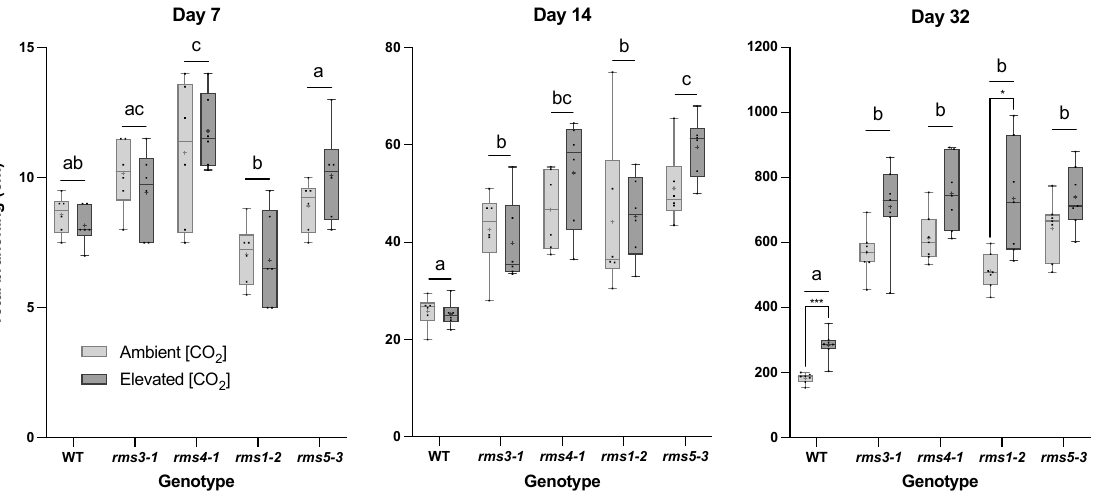
Figure 2. The effect of high CO 2 on the branching of the shoots of wild type peas and mutants defective either in strigolactone (SL) synthesis ( rms1 - 2 and rms5-3 ) or signaling ( rms3 - 1 and rms4-1 ). Plants were grown for up to 32 days either under ambient (420 ppm) or high CO 2 (750 ppm). Different letters indicate a statistically significant difference ( p ≤ 0.05) between genotype at each time point, while a significant difference between [CO 2 ] within genotype is indicated as: * p < 0.05; *** p < 0.001. Day 7 and day 14, n = 6; day 32, n = 7. Mean indicated as +.